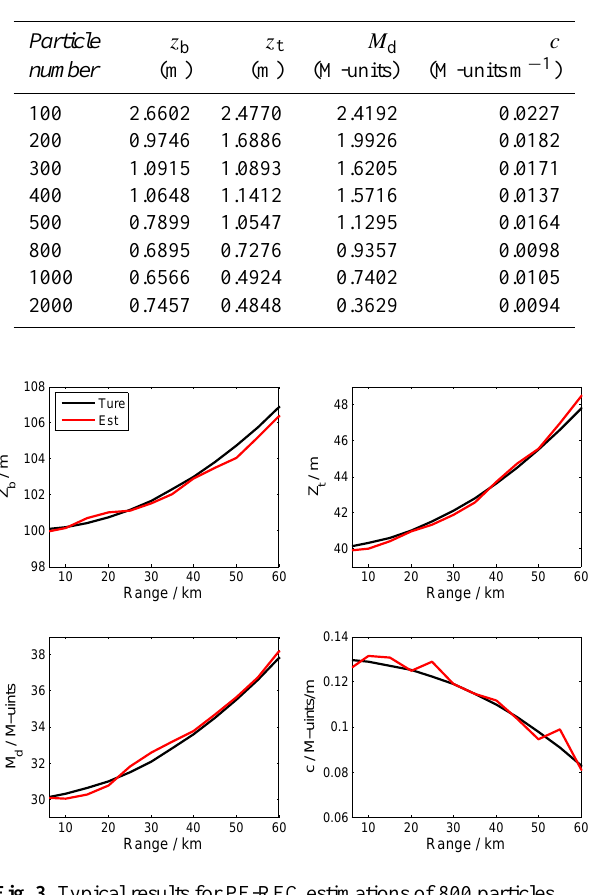
Fig. 3. Typical results for PF-RFC estimations of 800 particles.